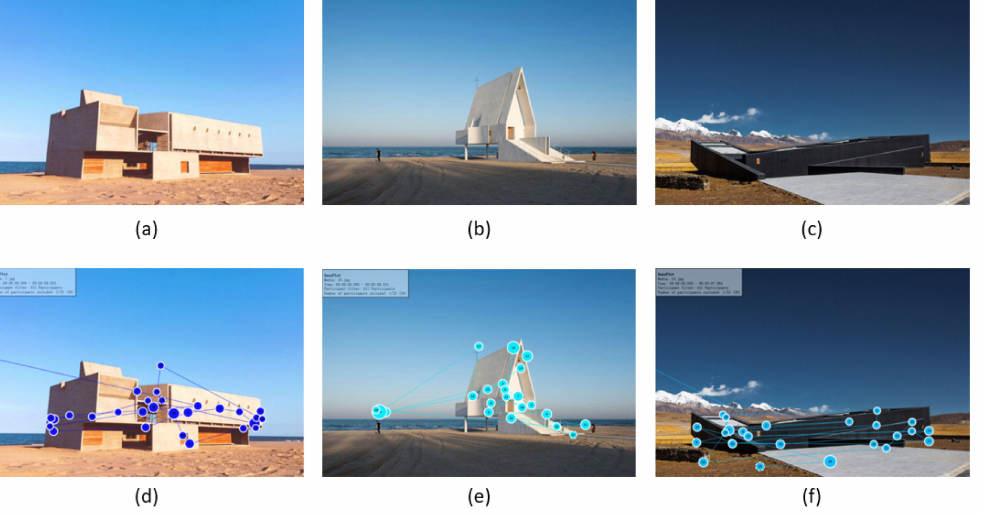
Figure 9. Fixation trajectories of the experiment 2: ( a ) Sample 4; ( b ) Sample 5; ( c ) Sample 6; ( d ) Sample 4 fixation track map; ( e ) Sample 5 fixation track map; ( f ) Sample 6 fixation track